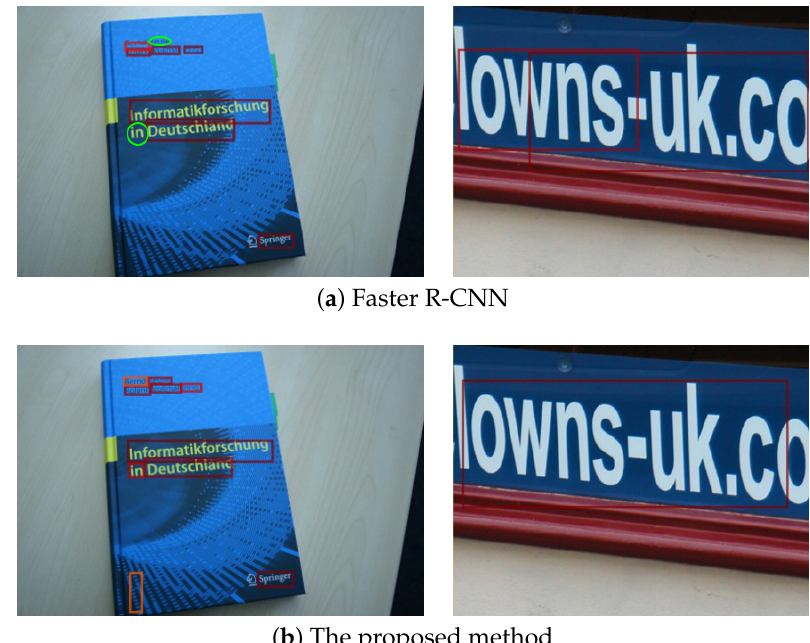
Figure 1. Detection examples. ( a ) Faster R-CNN (convolutional neural network) failed to detect small texts and detected large texts only partially. Green circles are the missed texts. ( b ) The proposed method detected small and large texts successfully. Although, there is the false-positive detection in the left